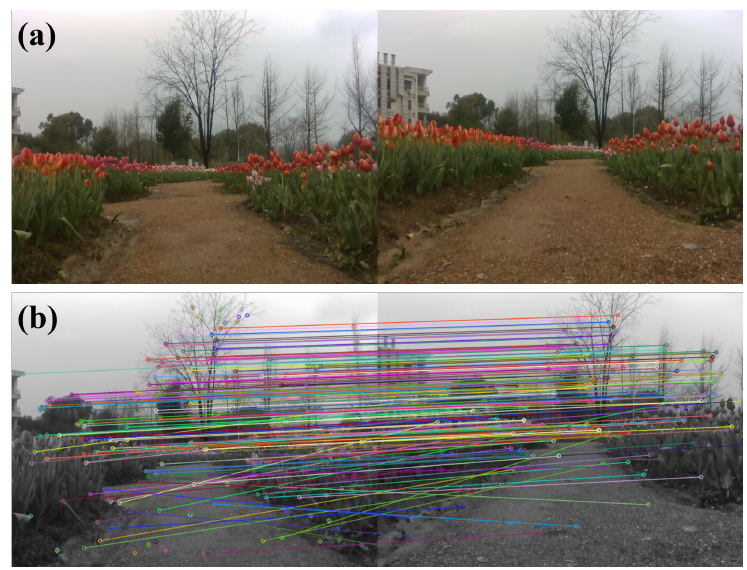
Figure 8. Feature rough matching. ( a ) Matching image; ( b ) results of feature